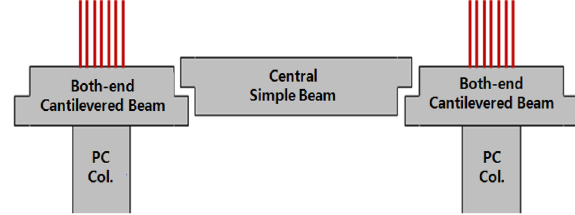
Fig. 1. Concept of the segmented PC beam system